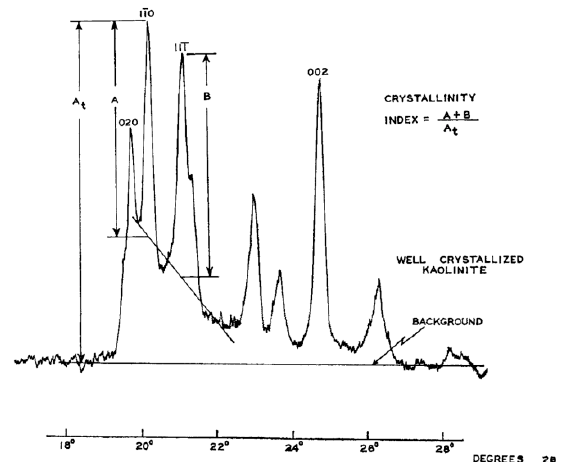
Figure 1. Calculation of the Hinckley crystallinity index for kaolinite [26].